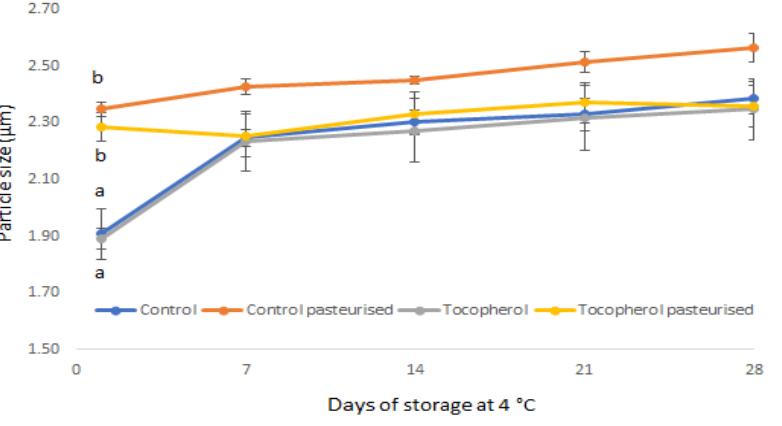
Figure 4. Particle size of oil droplets in yogurt-based beverages during refrigerated storage (28 days). Values are the mean ± SD.